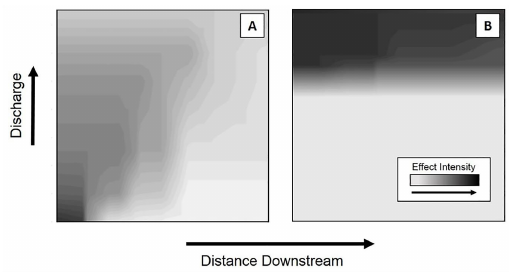
Figure 1. Theoretical spatial relationships between discharge and the potential impact of waste streams on ecosystem structure and function and the provisioning of ecosystem services. (A) The effect of a relatively constant, localized source of pollution entering a watershed (e.g, unintentional leak in sewer system) may experience decreases in the localized effect, but increases the spatial extent of the effect downstream at high flows; (B) Conversely, other sources of wastewater pollution (e.g., intentionally-designed combined sewer overflow) are only present during high flows and can have large, but infrequent effects locally and downstream.